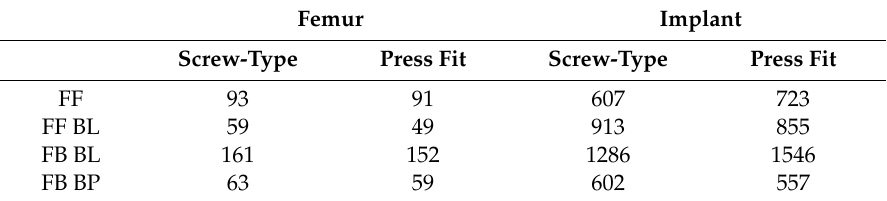
Table 3. Peak values of the equivalent stress (MPa) calculated for different fall scenarios: Fall Forward (FF), Fall Forward with Balance Loss (FF BL), Fall Backwards with Balance Loss (FB BL), Fall Backwards “By Push” (FB BP).